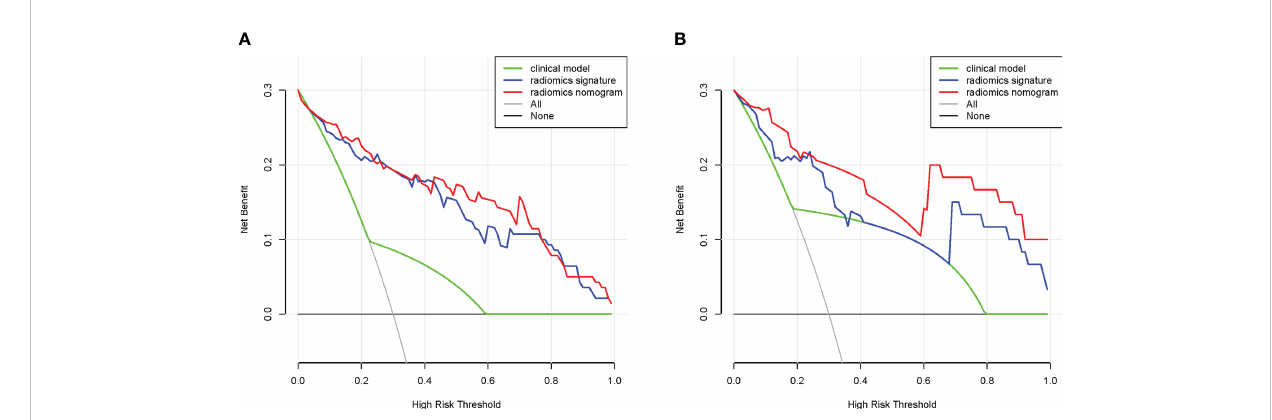
FIGURE 8 DCA of the nomogram in the training (A) and validation (B)